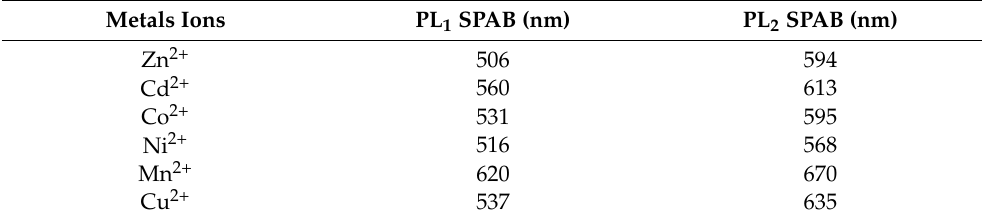
Table 2. Wavelength position of the second SPABs in nm obtained by spectra deconvolution using a lognormal distribution.